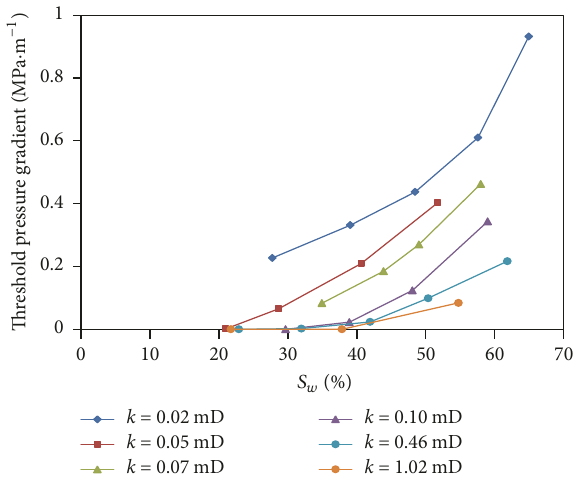
Figure 1: The relationship between water saturation ( 𝑆 𝑤 ) and threshold pressure gradient for different permeabilities.